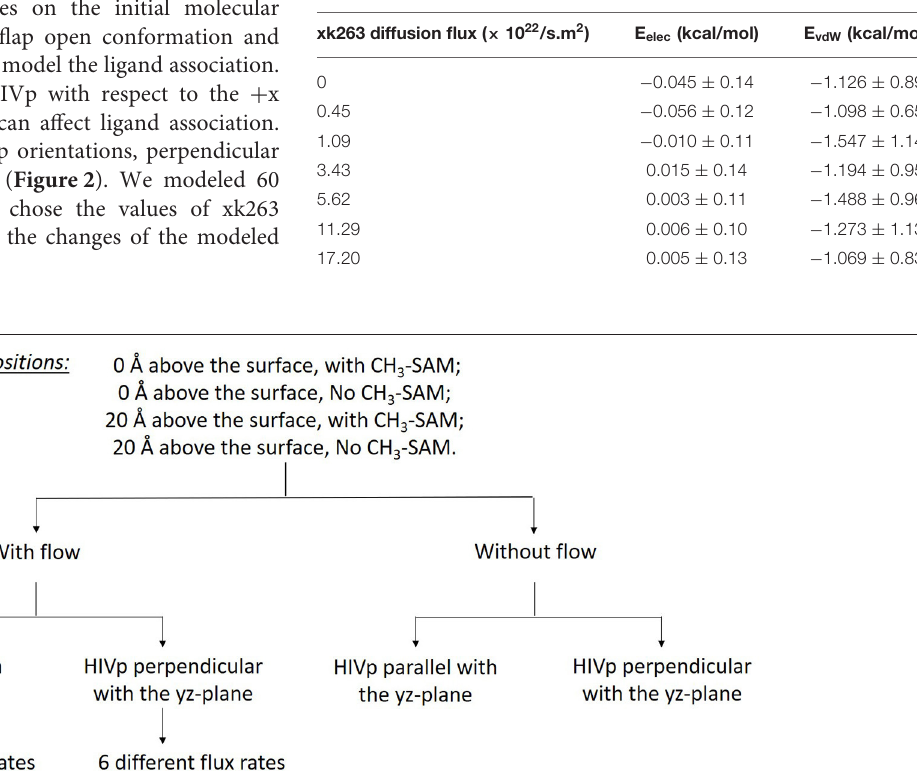
FIGURE 4 | Sixty different systems used in this study. The two HIVp orientations are shown in Figure 2 .